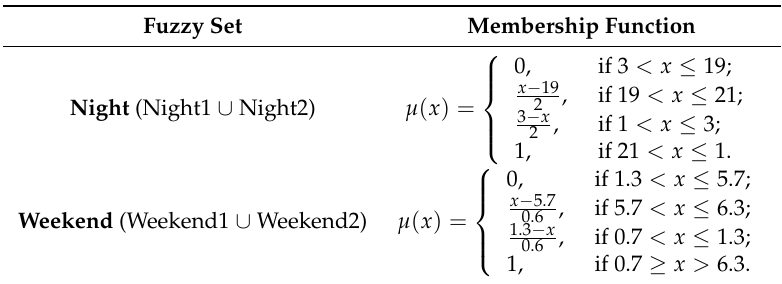
Table 1. Membership Functions for Weekend and Night Fuzzy